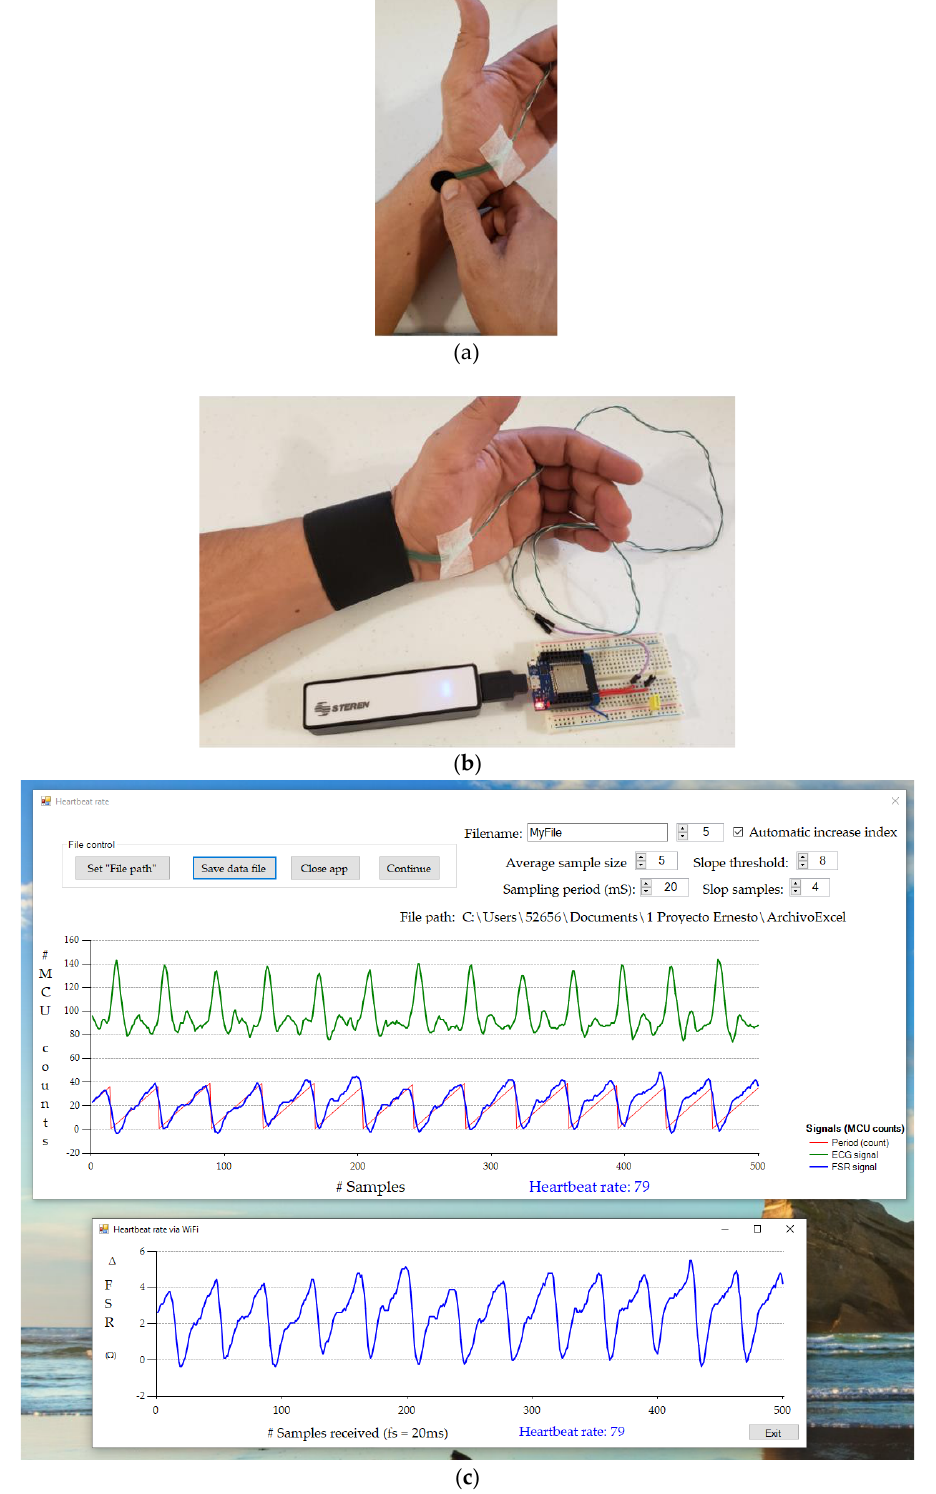
Figure 4. Prototype of the wearable sensing approach for remote heart rate monitoring. ( a ) FSR placed over the radial artery; ( b ) FSR with a Velcro wristband connected to a DIC; ( c ) graphical interface for remote visualization of the heartbeat signal and HR value.